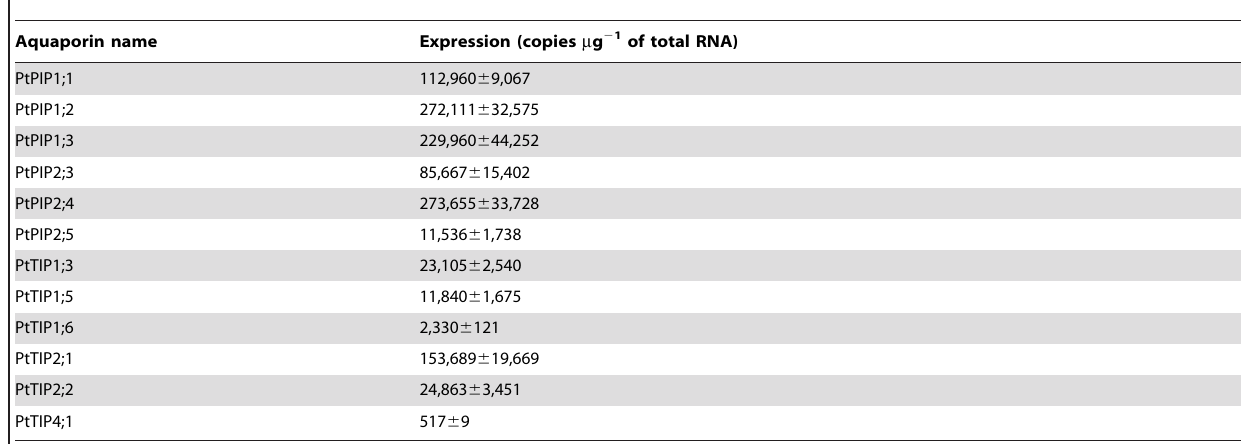
Table 1. Transcript abundance of 12 aquaporin genes expressed in leaves of well-watered control plants.